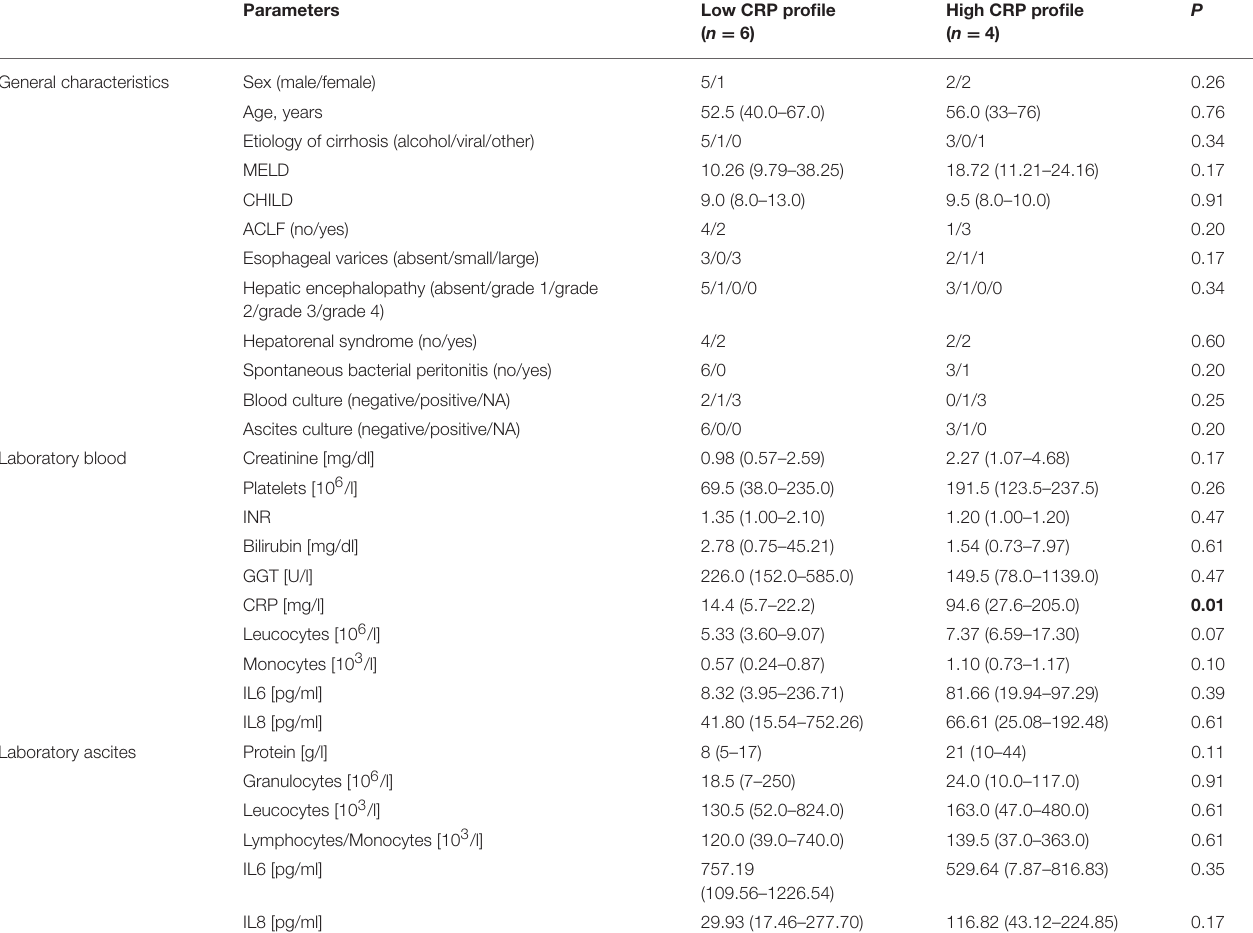
TABLE 2 | Patient characteristics for the subpopulation in which 16S rRNA gene amplicon sequencing was performed in blood and